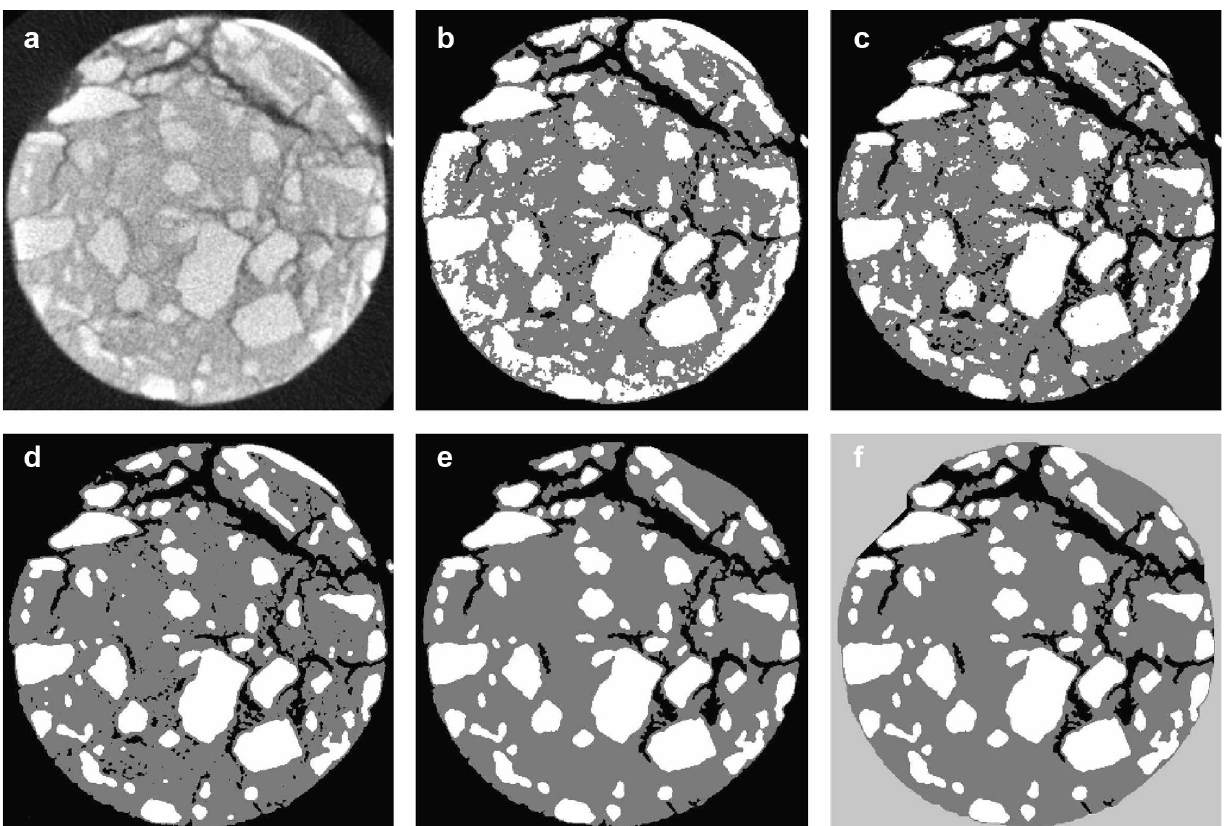
Fig. 3 Illustration of CT image processing, identification and acquisition ( a – f represent the imaging results of noise removal, multiple-threshold segmentation, gray value compensation, partial smoothing, noisy-particle elimination and background extraction,